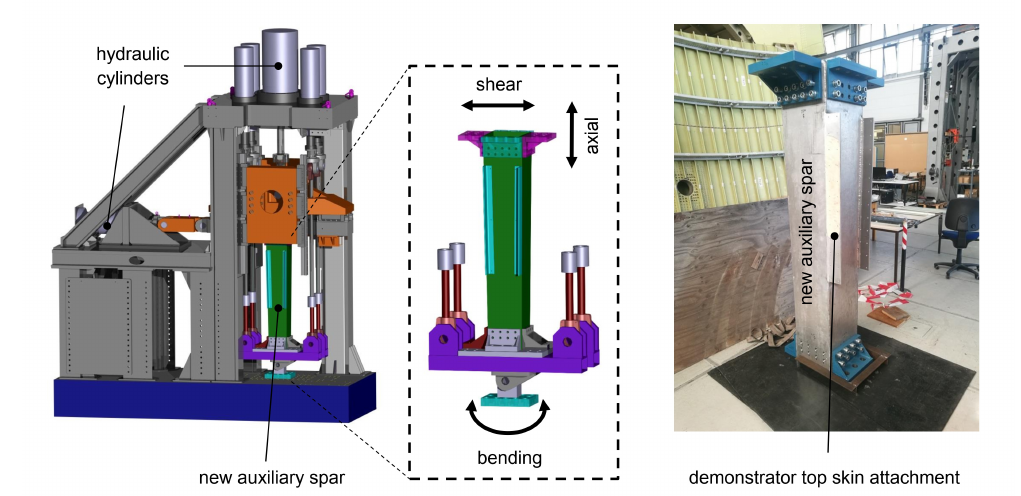
Figure 20. Images of the test rig to be used for conducting bending tests of the demonstrator. (Arrows display the modes of motion made possible by individual control of the large hydraulic